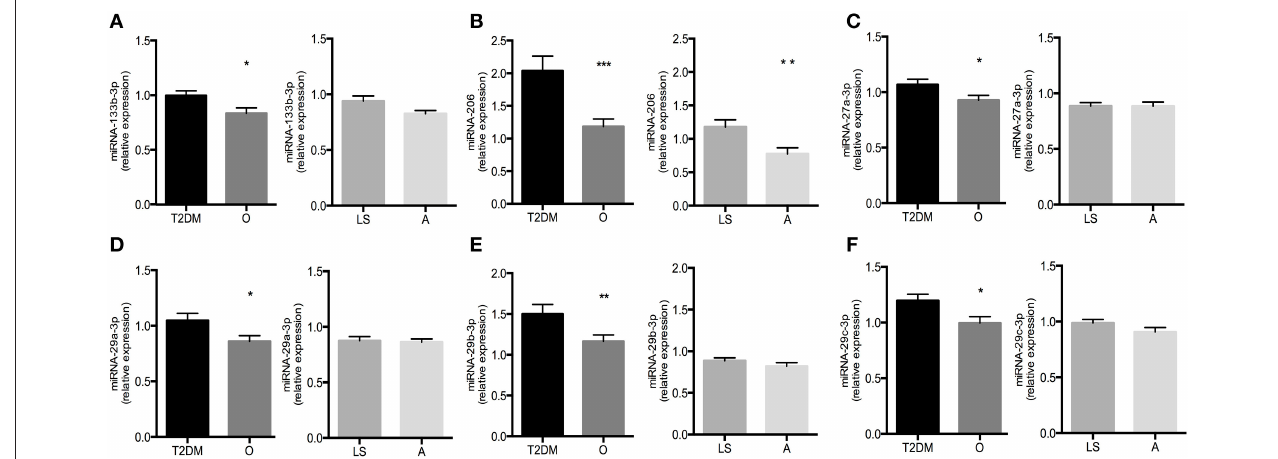
FIGURE 2 | Relative expression levels of miR-133b-3p (A) , miR-206-5p (B) , miR-27a-3p (C) , miR-29a-3p (D) , miR-29b-3p (E) , and miR-29c-3p (F) in type 2 diabetic subjects (T2DM) vs. non-diabetic overweight/obese individuals (O) and lean sedentary individuals (LS) vs. endurance-trained athletes (A). Significance is indicated with *, **, and *** representing p < 0.05, p < 0.01, and p < 0.001, respectively. Graphs represent mean ± SEM.